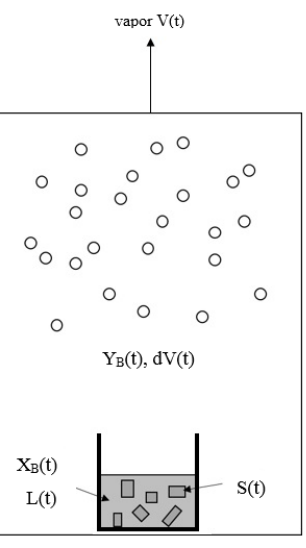
Figure 3. Schematic diagram of SC for a liquid mixture during a series of three-phase transformations, where the vapor formed is removed while the solid product and the remaining liquid is kept in the sample container. The liquid is stirred by a magnetic bar.